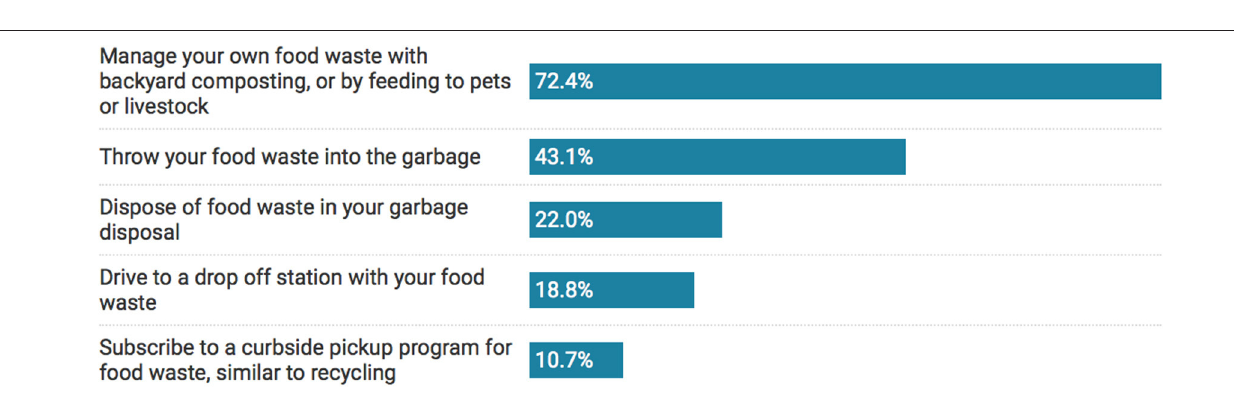
FIGURE 2 | Strategies used by respondents to currently manage their food waste. Respondents could choose more than one option.